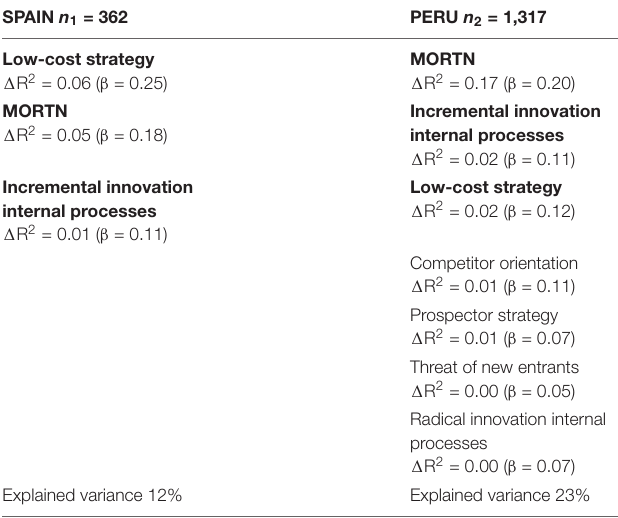
TABLE 10 | Summary of the predictive variables for the Hierarchy culture, sorted by the value of the R Change, from highest to lowest. SPAIN n 1 = 362 PERU n 2 = 1,317 Low-cost strategy (cid:49) R 2 = 0.06 ( β =